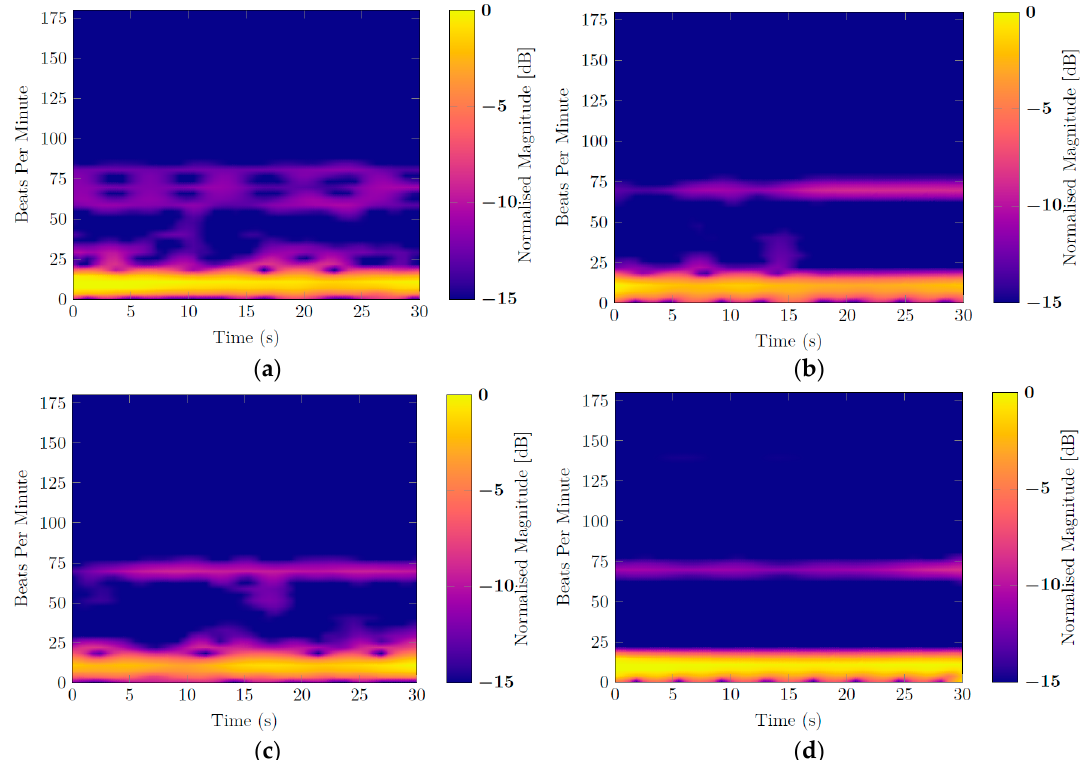
Figure 11. Spectrogram over 30s of the signal measured by the radar ( a ) with the chest of the subject ( b ) the left side, ( c ) the back, and ( d ) the right side facing the